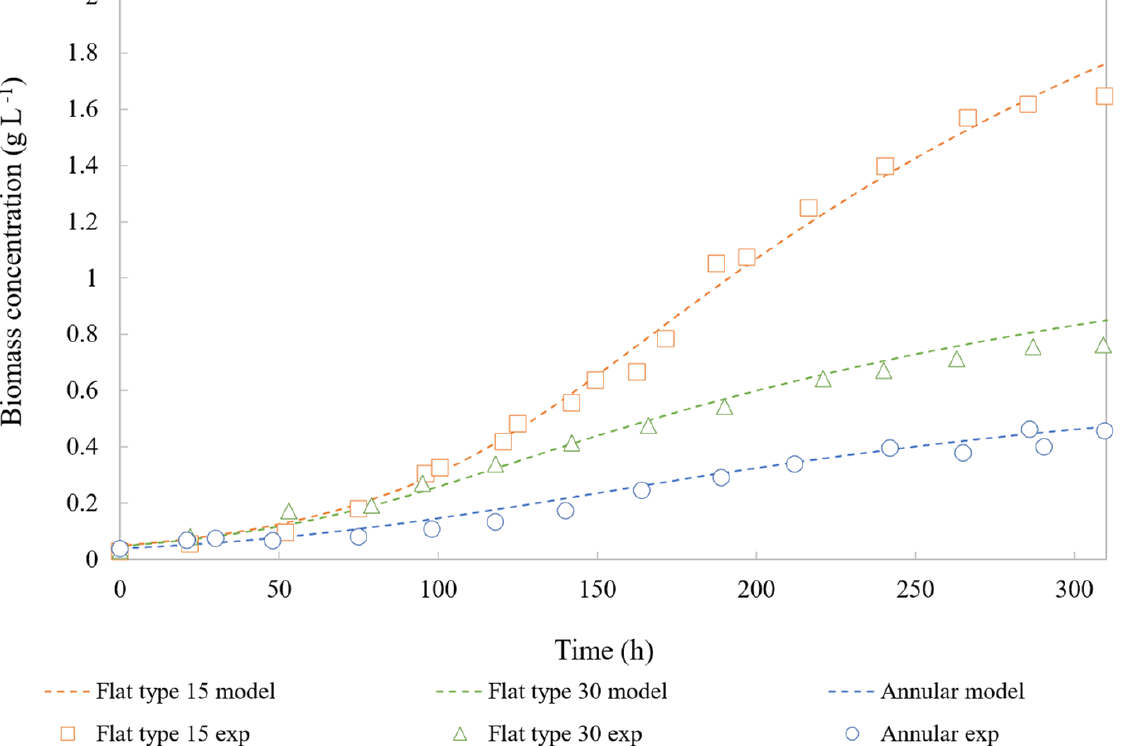
Figure 6. Comparison between model prediction and experimental data of Nannochloropsis gaditana growth curves in batch photobioreactors: “orange” Flat-plate 15 mm, “green” Flat-plate 30 mm, “blue” Annular photobioreactor. Dotted lines, model predictions; symbols, experimental data.